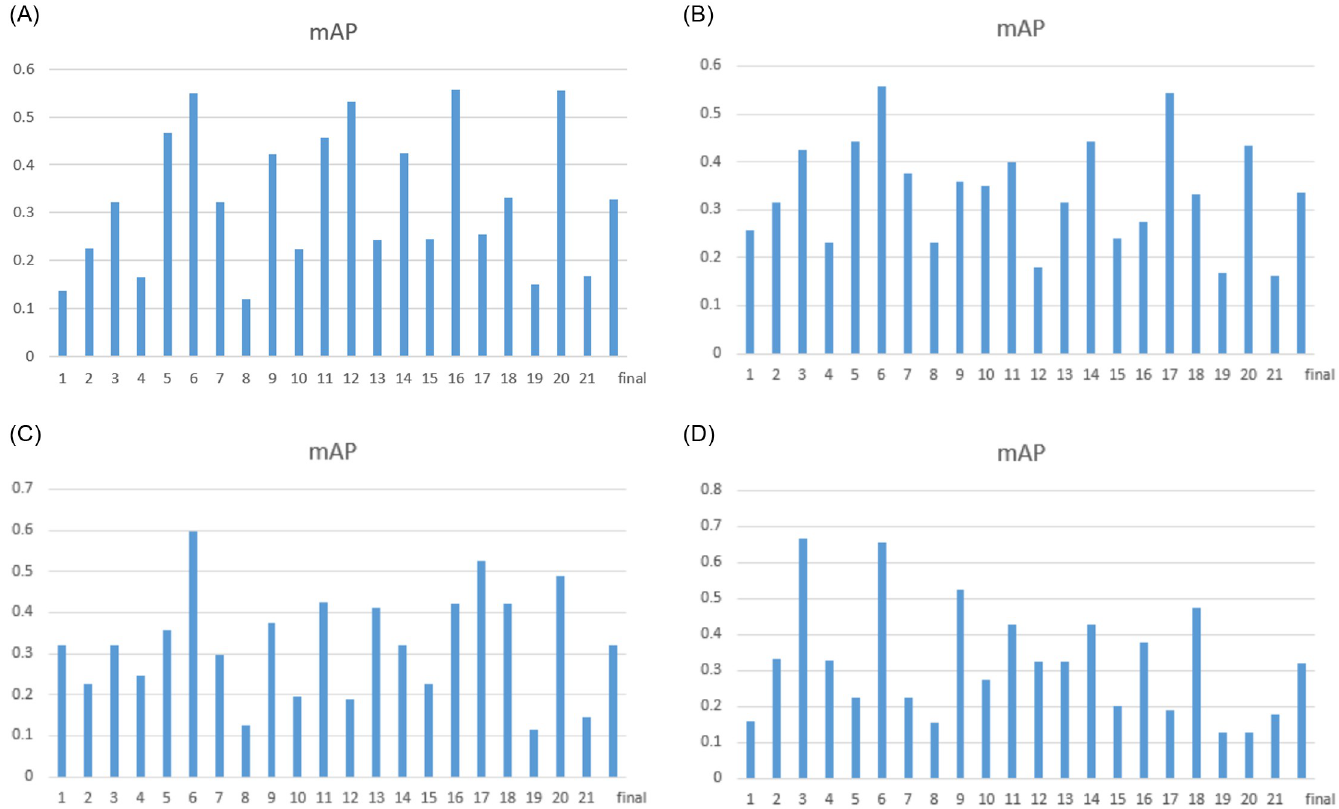
Fig 10. A comparison of image retrieval results with four texture features using EMDS-5.